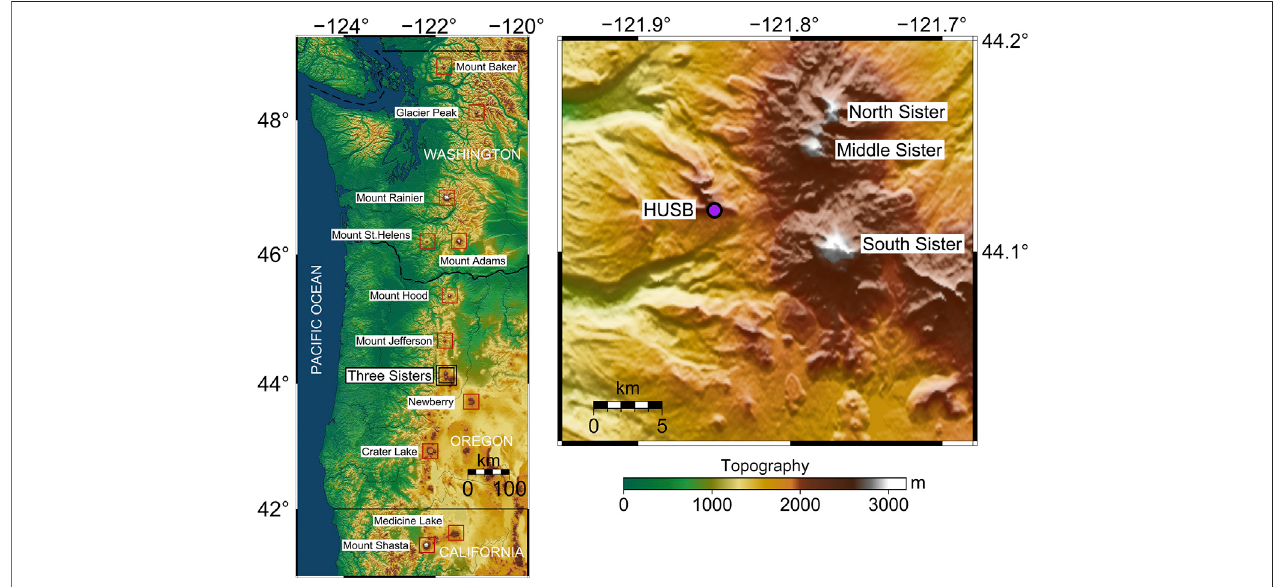
FIGURE 1 | (A) Shaded relief map for the Cascade range, with locations of representative Cascade volcanoes. Three sisters volcano is highlighted with black squares. (B) Regional map of Three Sisters volcano complex. The continuous GPS station HUSB, located at ∼ 5 km west of South Sister volcano, is shown as a purple circle with black